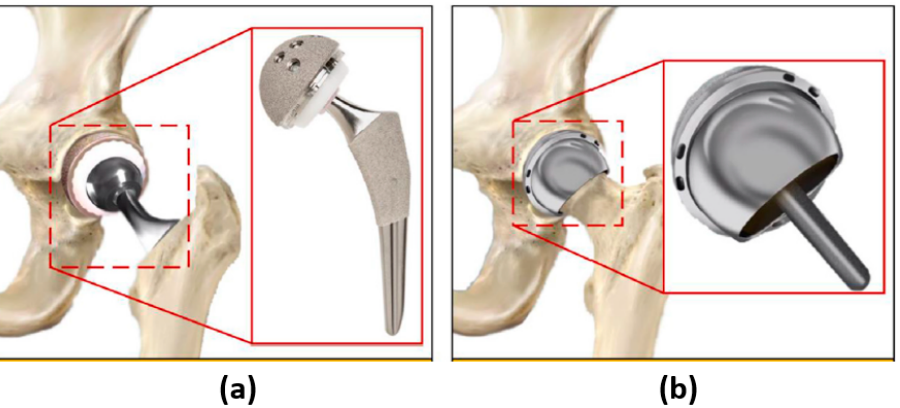
Figure 1. Total hip arthroplasty ( a ) and hip resurfacing ( b ). Reprinted/adapted with permission from Ref. [3]. 2022, Jamari, J.; Ammarullah, M.I.; Santoso, G.; Sugiharto, S.; Supriyono, T.; Permana, M.S.; Winarni, T.I.; van der Heide, E.